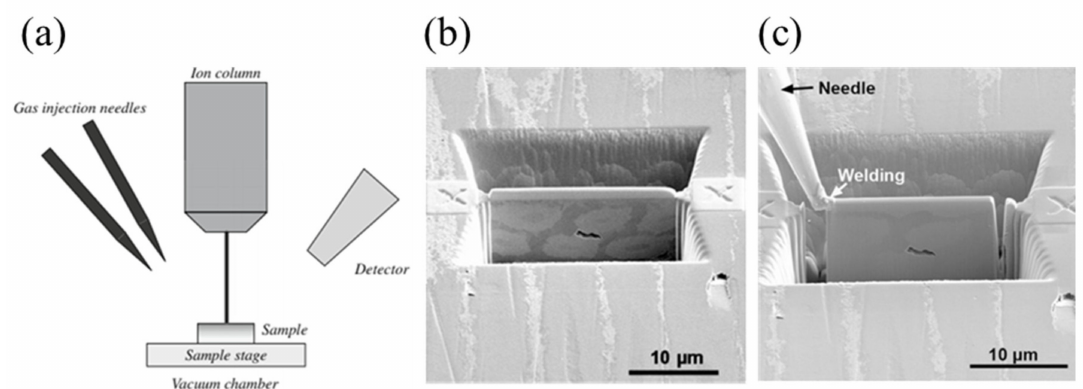
Figure 11. Focused ion beam TEM specimen preparation ( a ) layout positioning of the ion beam, secondary electron (SE) detector and the metallic source ( b ) milling trenches with low voltage and weak current. SEM image in secondary electron. ( c ) welding platinum between the slice and the needle (micromanipulator) [124]. Reprinted from [124] with permission from Springer Science & Business